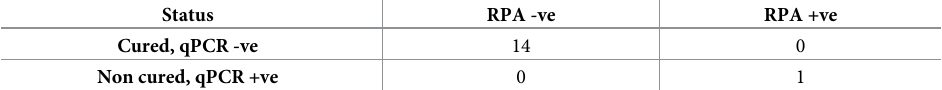
Table 5. Determination of prognostic positive and negative predictive values of RPA vs. qPCR in cases of VL fol- lowing completion of treatment (n = 15). Status RPA -ve RPA +ve Cured, qPCR -ve 14 0 Non cured, qPCR +ve 0 1 Peripheral blood was collected from patients with VL upon completion of treatment and was evaluated by RPA as described in materials and methods, the qPCR being the gold standard. Patients were considered ‘cured’ when they were qPCR -ve and ‘non-cured’ when they were qPCR positive, VL: visceral leishmaniasis.